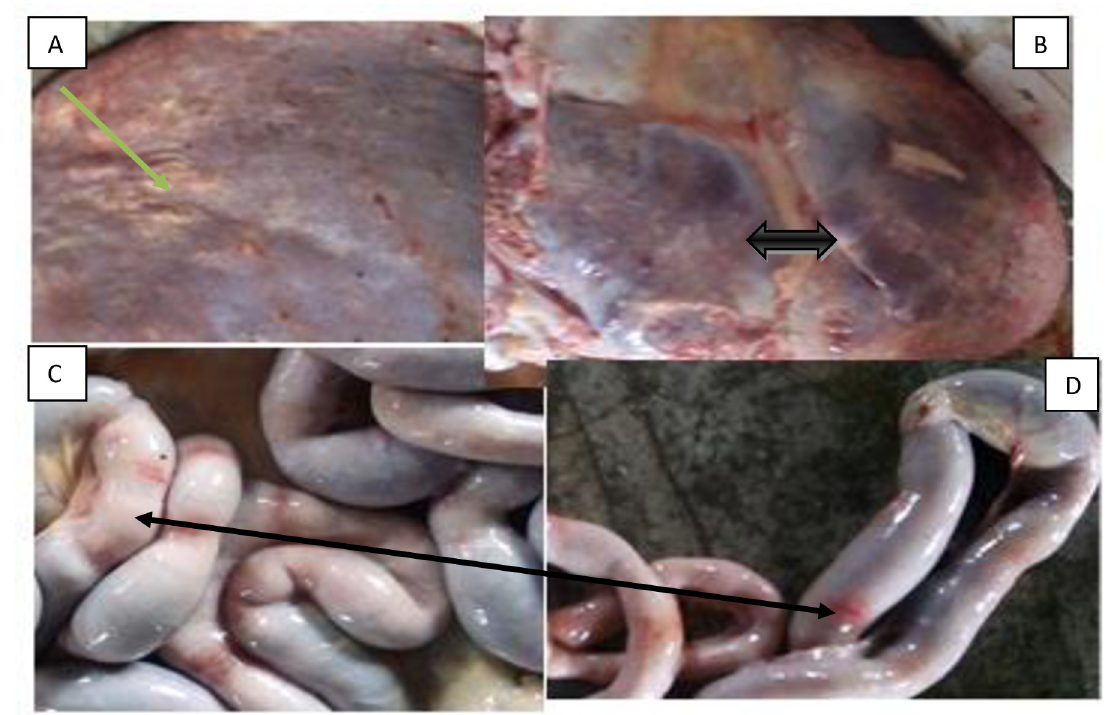
Fig 3. Lesions induced by S.bovis in the liver and intestinal tract of cattle. Lesions induced by S.bovis in the liver and intestinal tract of cattle. The single arrow in picture “A ” presents hardened and extensively fibrosed multiple, elevated greyish nodules in the live and the short double arrow in picture “ B ’ showed fibrosis and thickening of the portal tracts, the long double arrow in picture C and D indicates hemorrhagic enteritis.